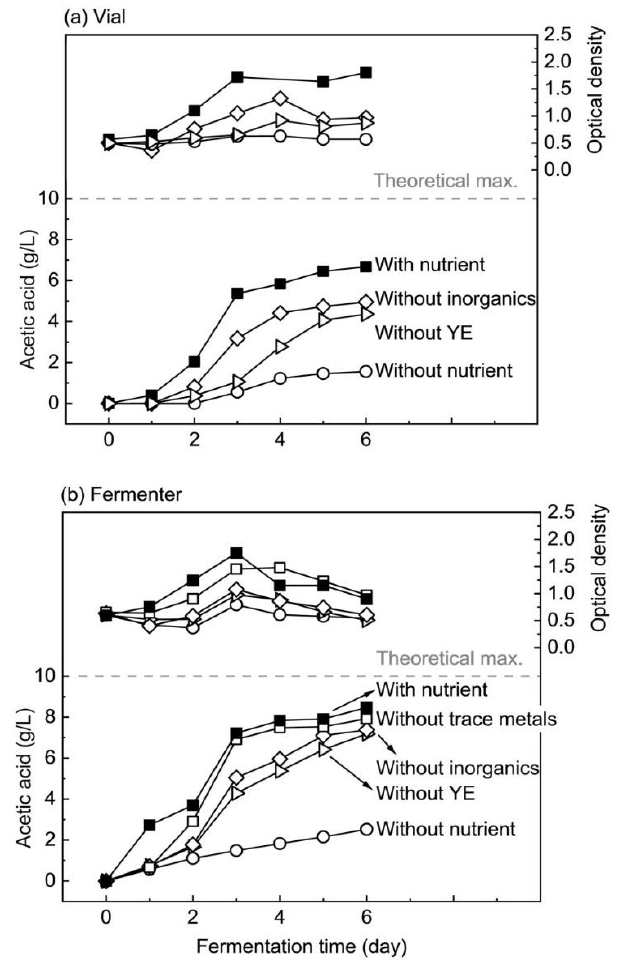
Figure 3. Comparison of acetic acid production and cell growth from fermentation of hydrolyzed nipa sap by M. thermoacetica in ( a ) vials and ( b ) fermenters with full nutrient (filled square), without trace metals (open square), without inorganics (open diamond), without yeast extract (open triangle), and without nutrient (open circle).